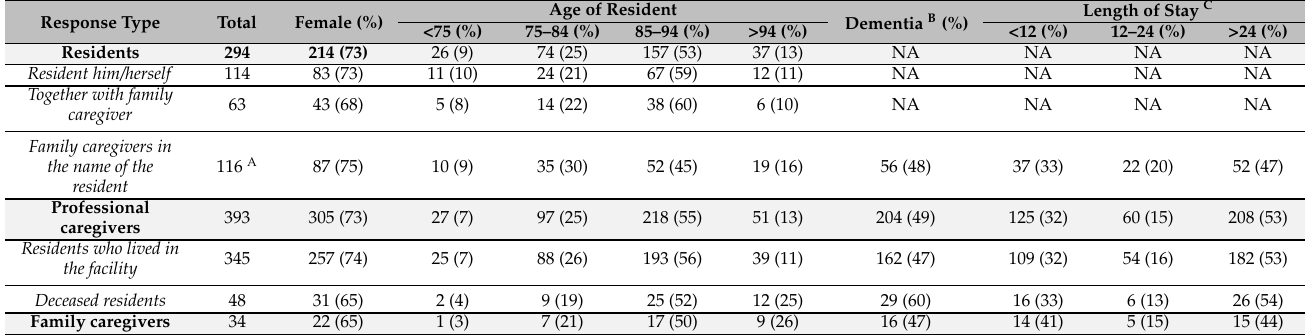
Table 5. Characteristics per response type in the pilot